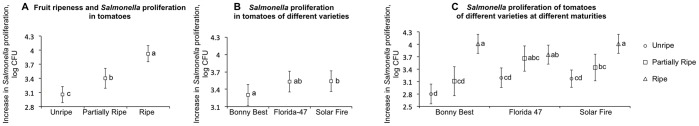
Effects of tomato genotype and fruit ripeness on proliferation of Salmonella.Tomatoes (cultivars Bonny Best, Solar Fire and Florida-47) were harvested in the field as for the commercial harvest, infected with 102 CFU of Salmonella and incubated for a week. Maturity stages of the fruits at the time of infection with Salmonella were assessed using the USDA guide for tomato maturity. Tomato ripeness was assessed using USDA maturity chart. Tomatoes that were at stages 5 or 6 at field harvest were considered “ripe”, those that were harvested at stage 4 or below and then ripened during the experiment, were considered “partially ripe”, and those that were harvested at stage 3 or below and did not ripen beyond stage 5 during the experiment were considered “unripe”. An increase in Salmonella proliferation per fruit, relative to the initial inoculum is plotted. Medians are plotted, whiskers are standard errors. A. Effect of fruit ripeness as the main effect on Salmonella proliferation. B. Effect of the tomato genotype as the main effect on Salmonella proliferation. C. The effect of interactions between tomato genotype and maturity on Salmonella proliferation. Data from all samplings are included in each chart. Lower-case letters within the chart indicate groupings (p<0.05).